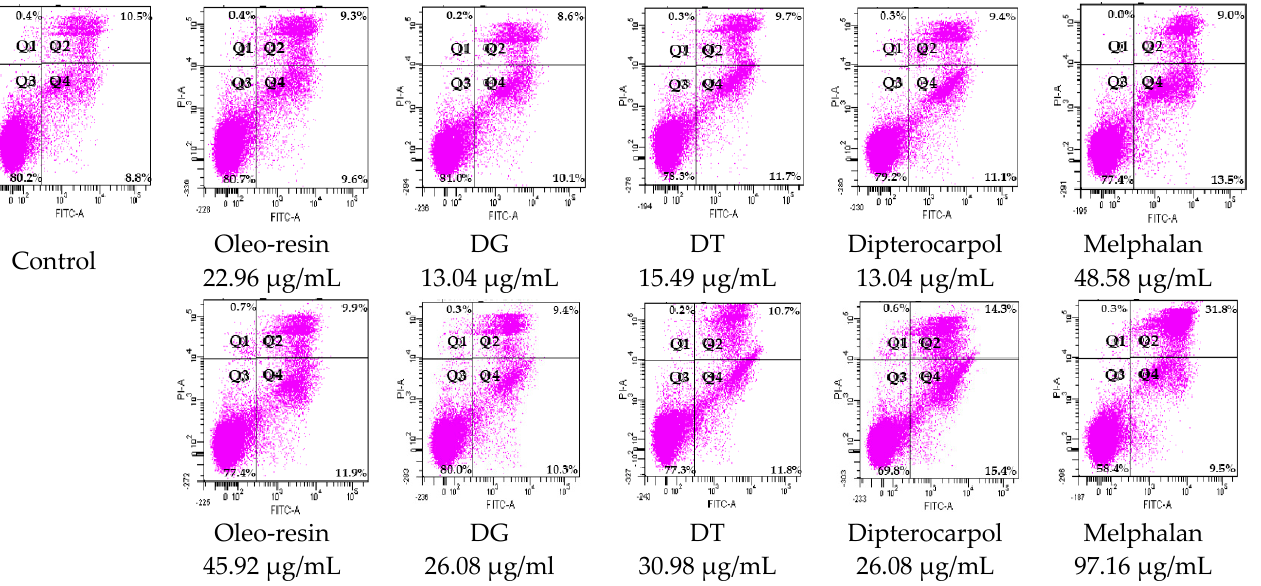
Figure 2. Cell dot plot represented the mode of cell death of oleo-resin and resin from different preparation processes and dipterocarpol at 1 × IC 50 and 2 × IC 50 concentrations after treatment for 24 h. Necrosis, late apoptosis, viable cell, and early apoptosis were shown in quadrant 1 (Q1) to 4 (Q4), respectively.